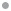
Proteolytic activity of the venoms of B. asper (sensu stricto), B. rhombeatus, and B. ayerbei (A) and neutralizing capacity of the antivenoms manufactured by INS-COL (●), PROBIOL (○) and ICP (●) towards B. asper (B), B. rhombeatus (C) and B. ayerbei (D). Neutralization of the proteolytic activity was measured on azocasein, as described in the Material and methods section, 90 min after mixing and incubating 12.5 μg of venom (challenge dose) with antivenom in the ratios indicated in the figure. Each point represents the mean ± SD of three replicates. Statistically significant differences (p<0.05) compared to the venom controls are represented by asterisks.